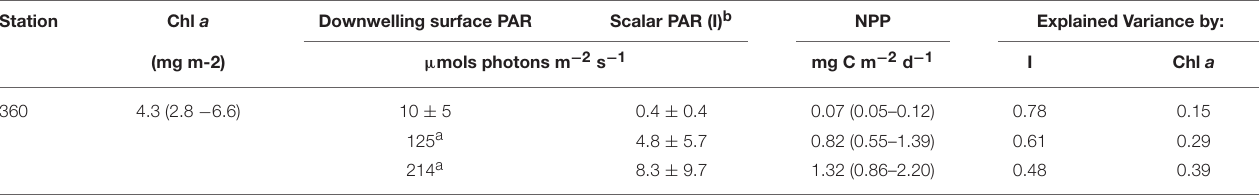
a Downwelling surface irradiance data presented in Gosselin et al. (1997) from the same region as station 360. b The bottom-ice scalar irradiance used to calculate NPP.